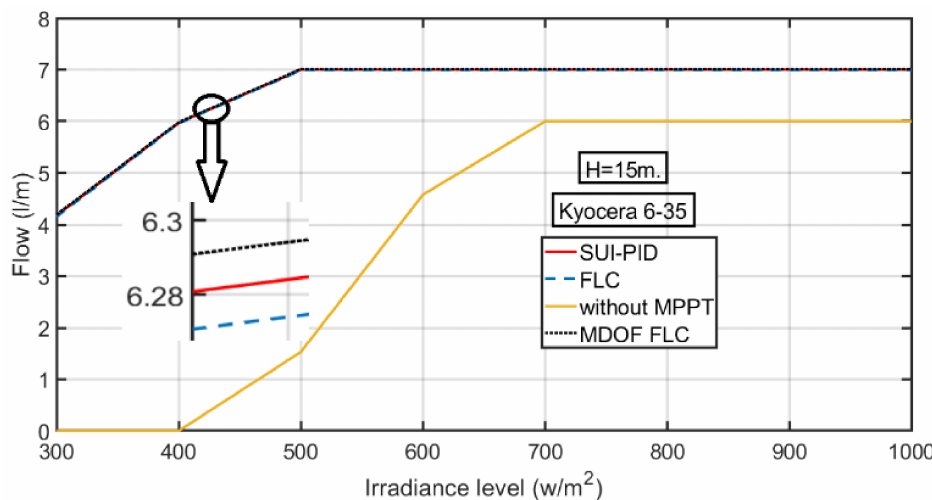
Figure 17. Performance analysis of the volume flow rate at a head of 15 m.